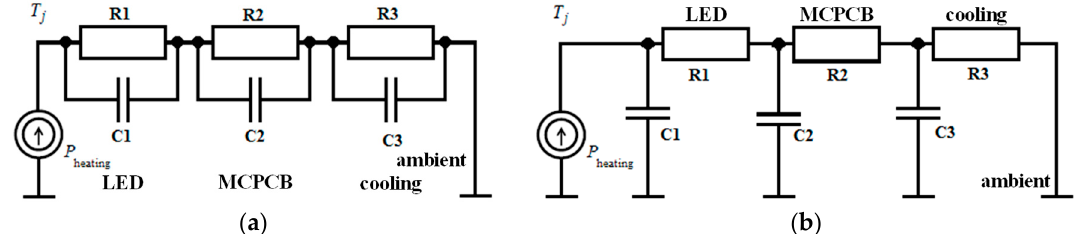
Figure 5. RC ladder compact thermal models: ( a ) Foster ladder; ( b ) Cauer ladder.